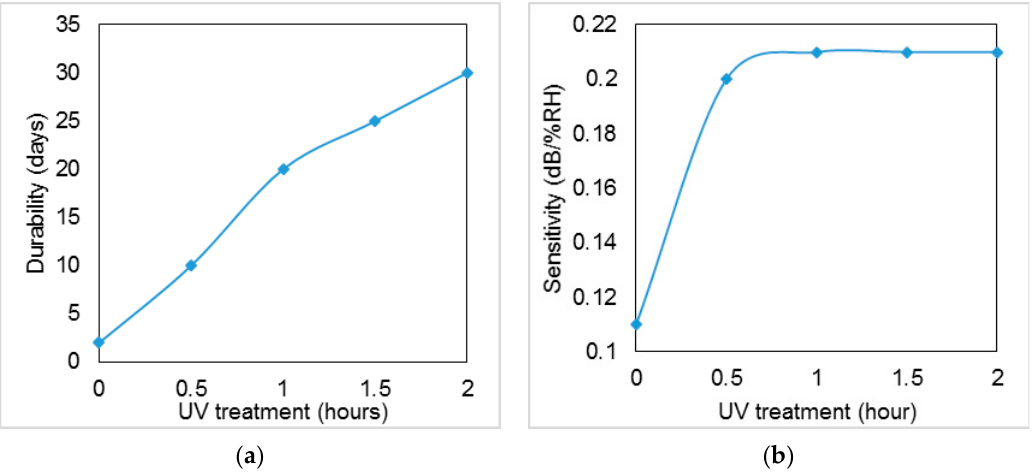
Figure 6. UV exposure effect on sensitivity ( a ) and stability or repeatability ( b ) of the proposed sensor.